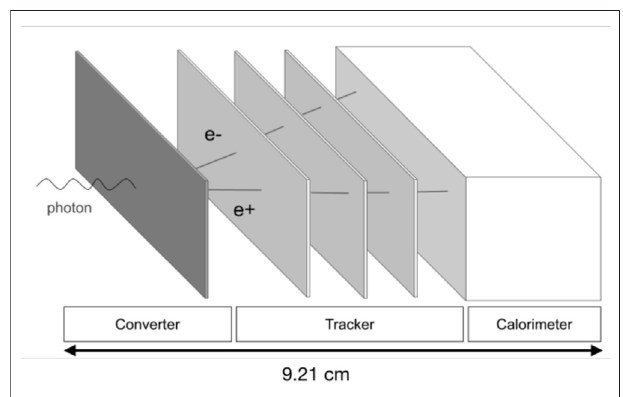
FIGURE 1 | Sketch of the PAPRICA design: the converter, the tracker, and the calorimeter blocks are shown. The total detector length is